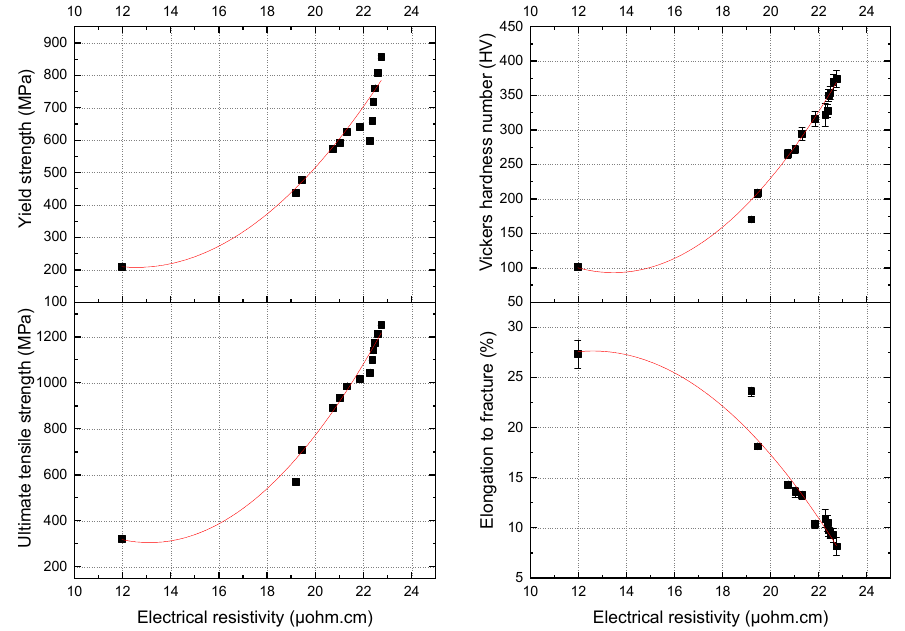
Figure 5. Correlations between electrical resistivity and yield strength ( top left ), ultimate tensile strength ( bottom left ), Vickers hardness ( top right ) and elongation to fracture ( bottom right ) including data obtained from carbon steels of groups A and B.